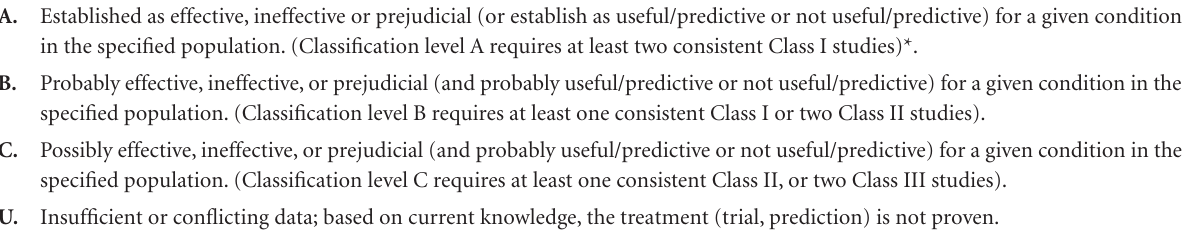
Table 1. Level of